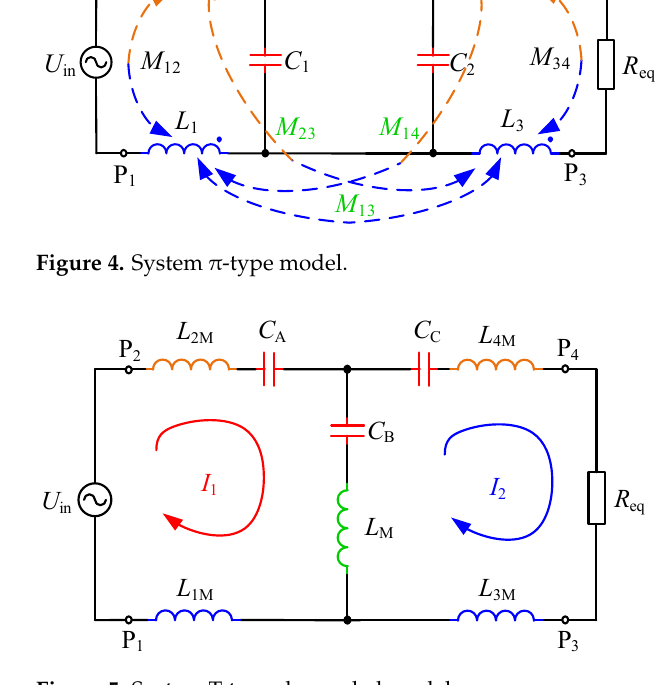
Figure 5. System T-type decoupled model.